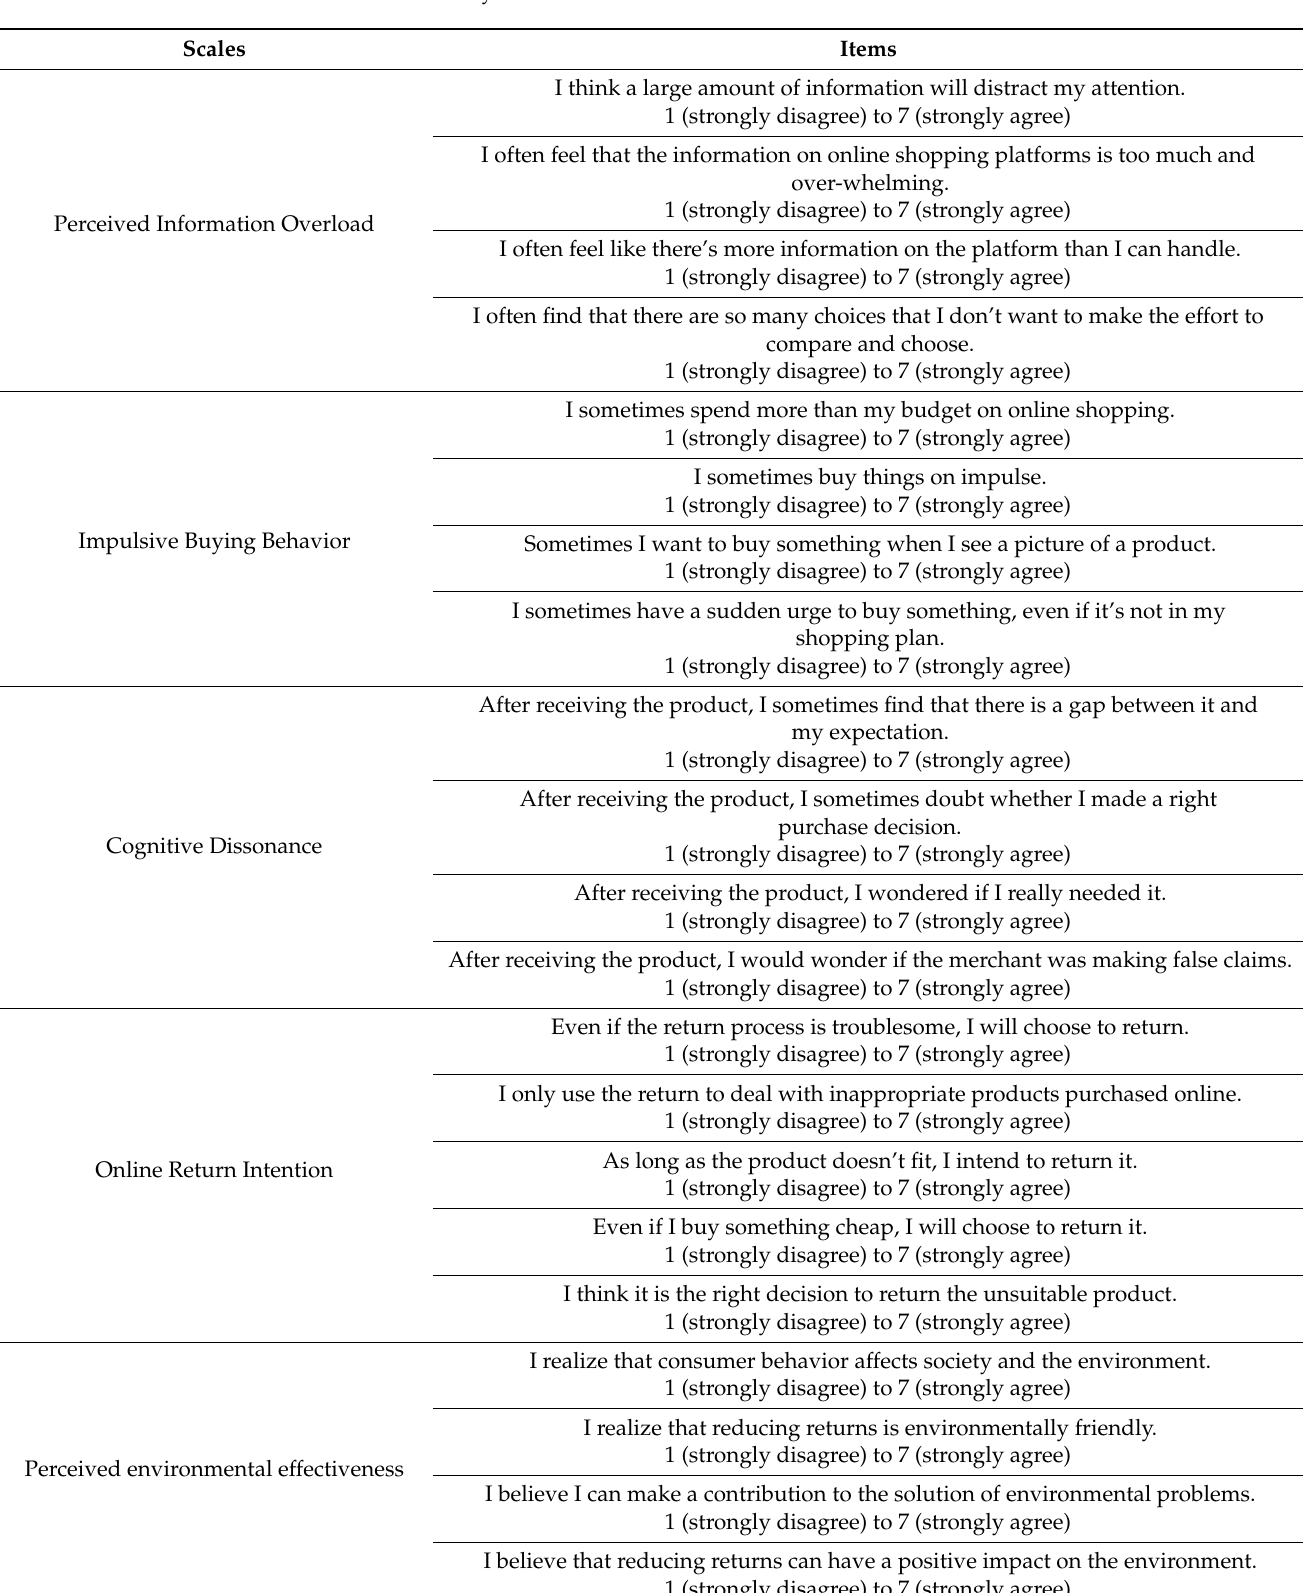
Table A1. Survey on Online Return